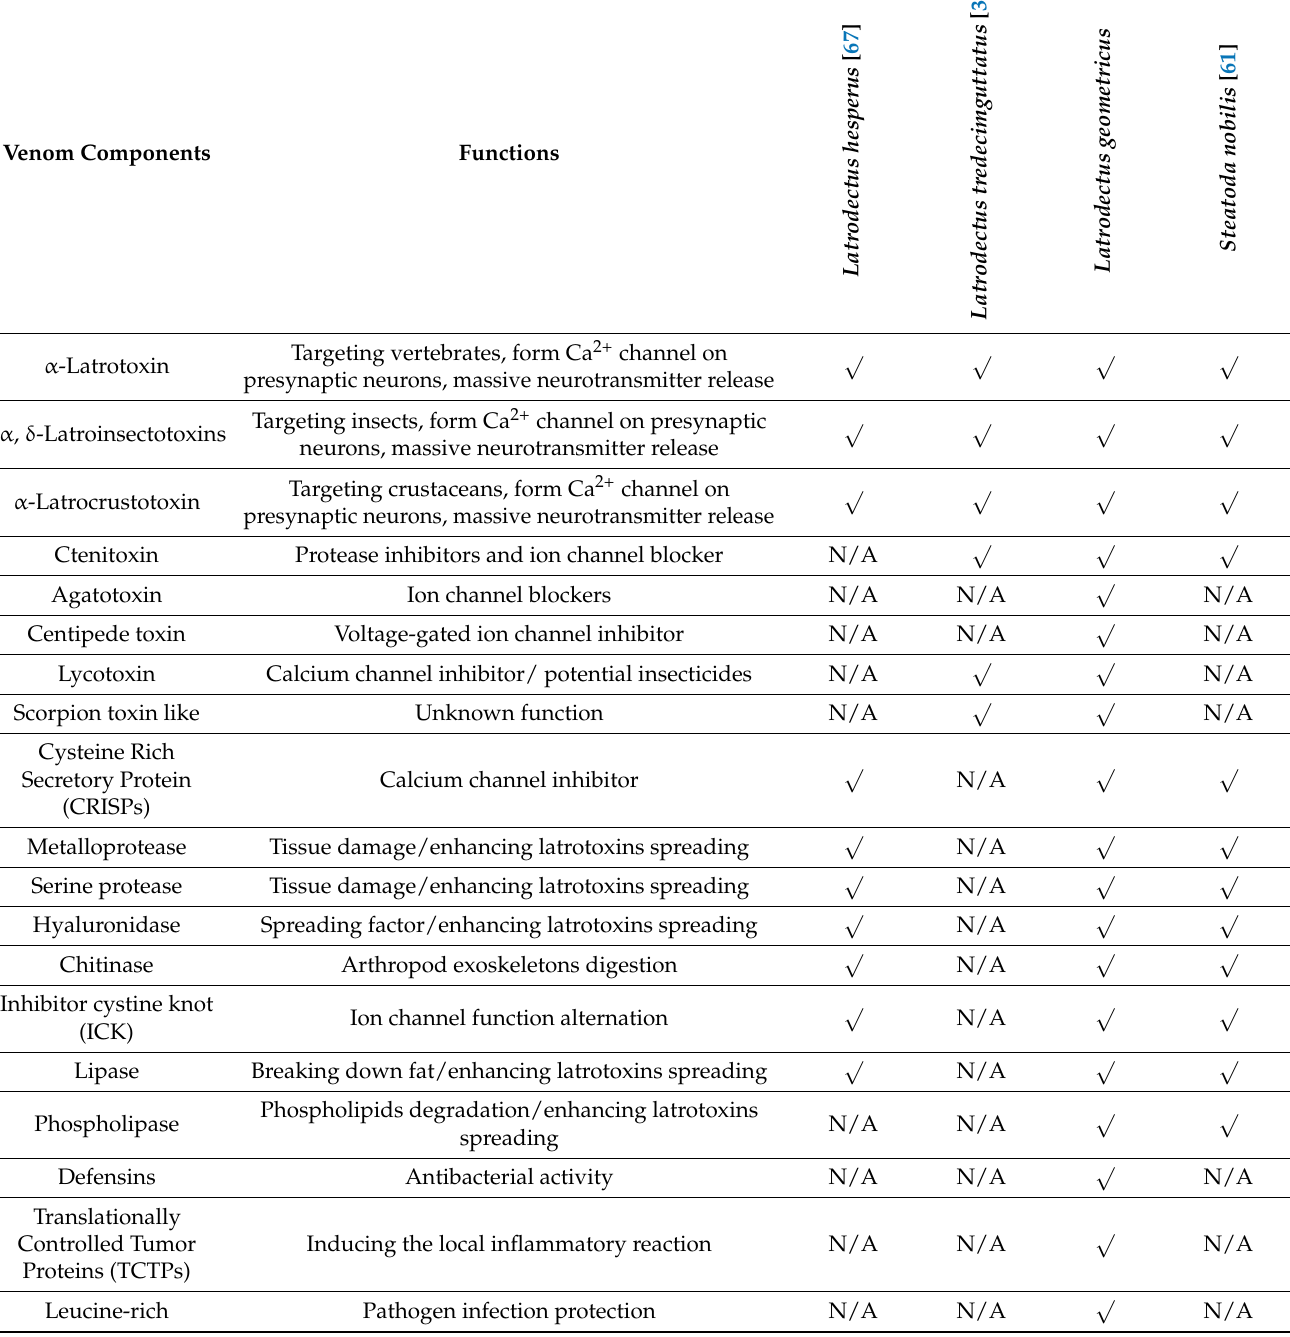
Table 3. Main venom components identified in the spider